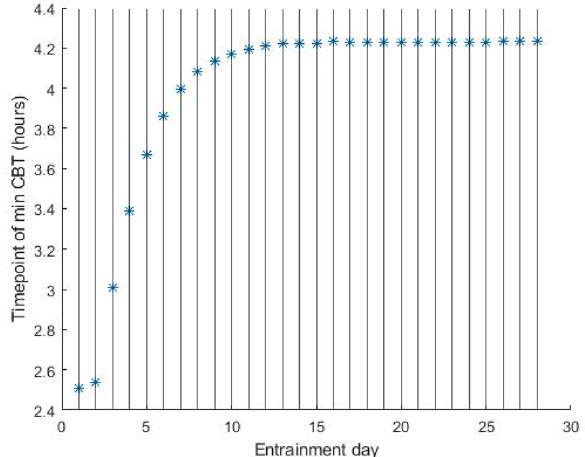
Figure 7. Example of daily shift in the predicted core body temperature minimum during entrainment. Results are presented for a 24 h light–dark cycle (LD 16:8 at 200 lx). Here, the model reaches a stable entrainment